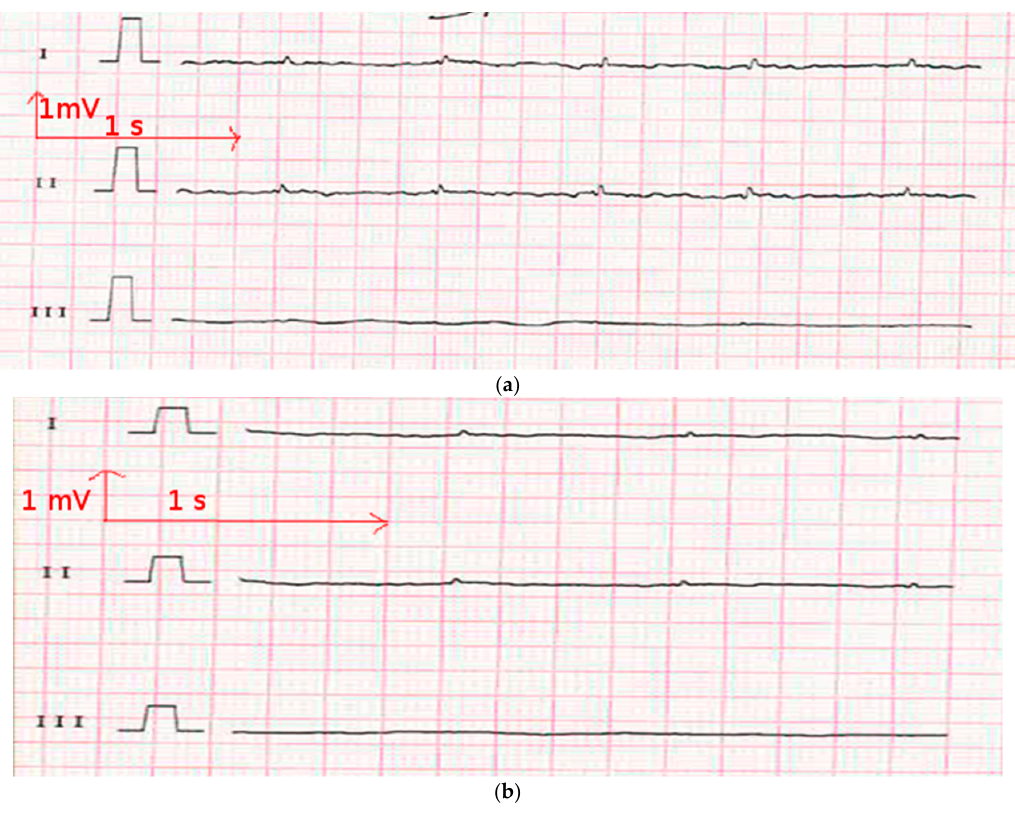
Figure 7. Electrocardiography at rest from the polyester electrode ( a ) before washing, and ( b ) after 50 washing cycles.